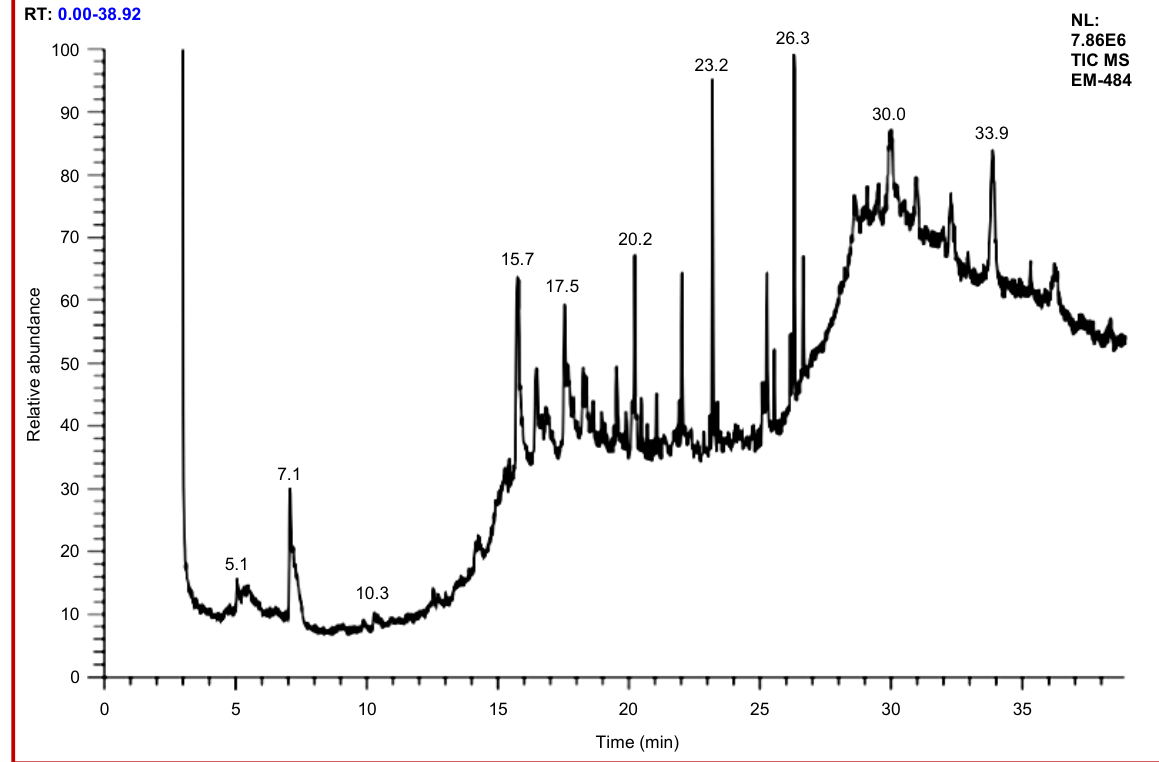
Figure 1: GC-MS chromatogram of ethanolic leaf extract of E.